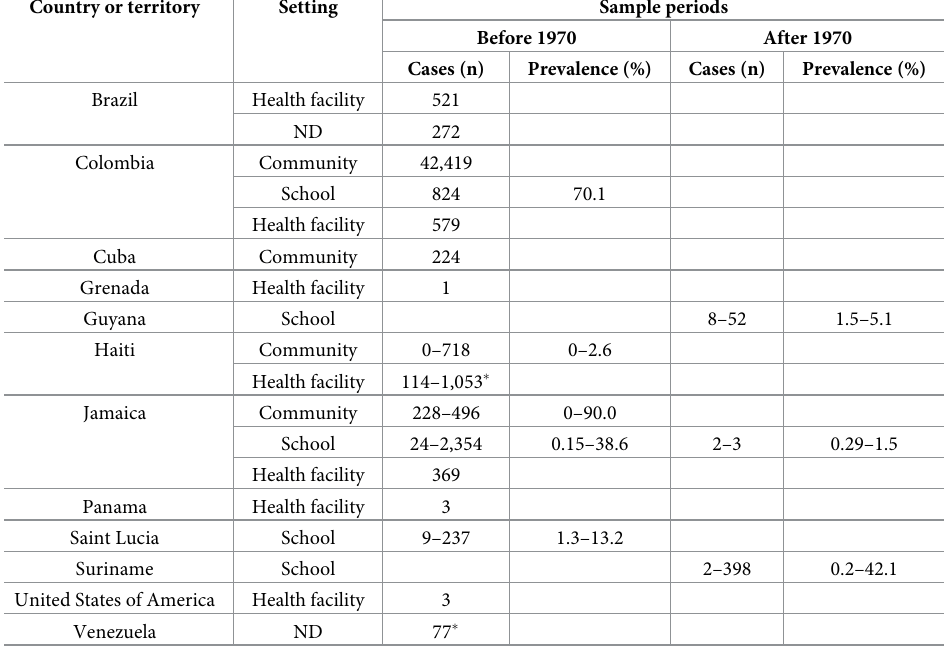
Table 3. Number of cases and prevalence of yaws (range) in children (0–16 years old) by country or territory, set- ting and sample period. Country or